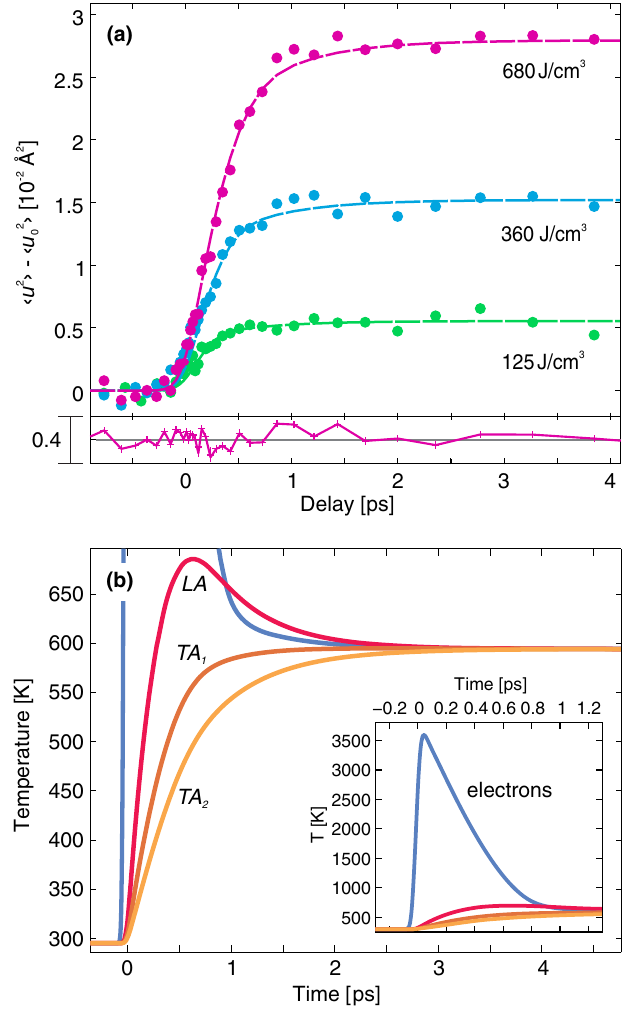
FIG. 5. (a) Measured mean-squared displacement (MSD) as a function of delay (circles) and calculated evolution predicted by the nonthermal lattice model with a phonon-phonon coupling of 3 . 5 × 10 17 W m − 3 K − 1 (lines). All other material parameters are taken from DFT calculations. In the bottom, the residuals for the highest excitation density are shown. (b) Evolution of the temperatures of electrons (blue) and the three phonon branches according to the NLM for an excitation density of 680 J = cm 3 . ð t Þ The inset shows the full range of T e